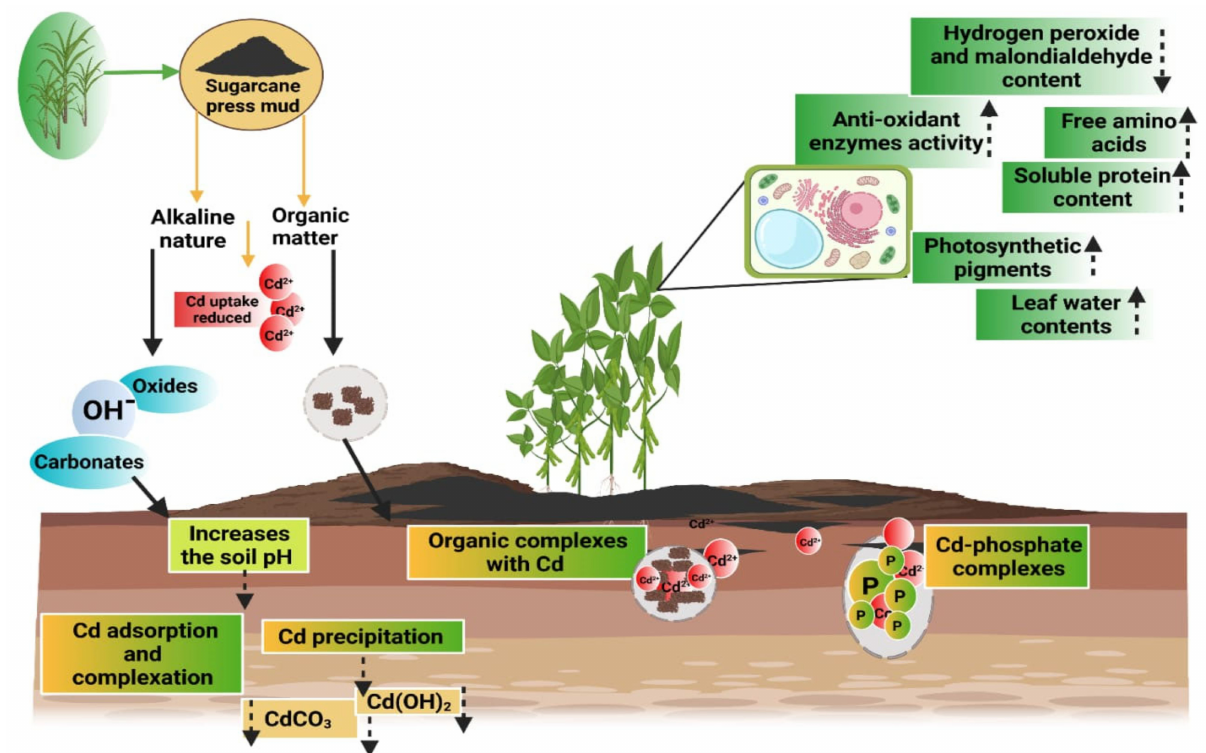
Figure 6. Proposed model for the effect of SPM in reducing the Cd toxicity in mash beans. SPM increases soil pH, Cd precipitation, Cd complexes with organic, anti-oxidant activities, TSP, FAA and RWC, photosynthetic pigments and reduce electrolyte leakage, MDA and H 2 O 2 accumulation and thereby reduce the Cd toxicity in mash